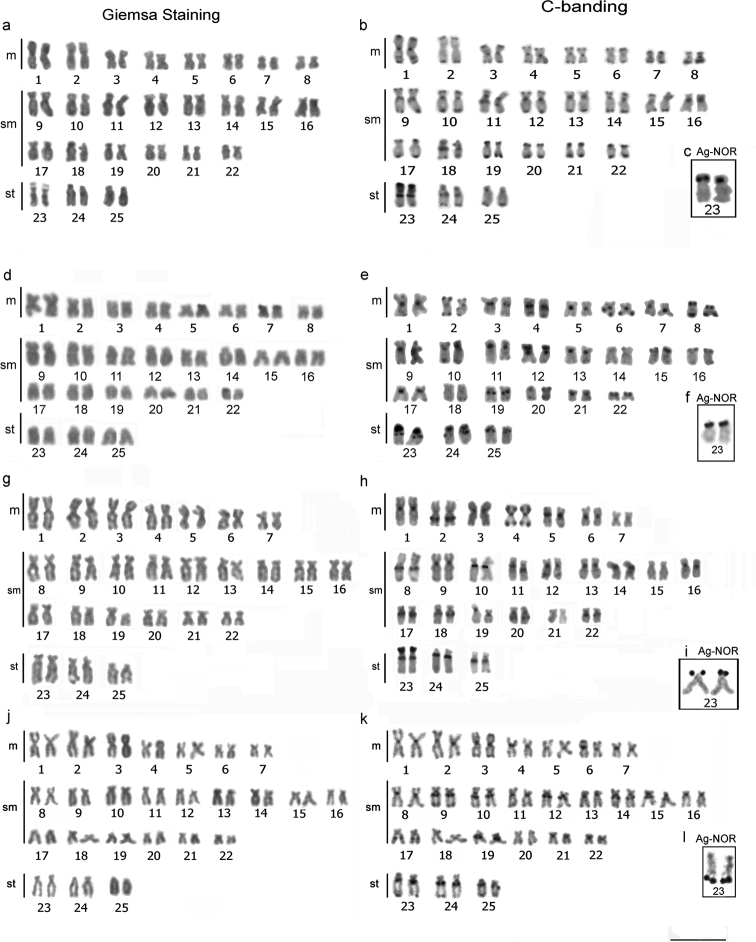
Karyotypes of the species under study arranged from chromsomes stained conventionally with Giemsa, C-banded, and after Ag-NOR impregnation: a–cA.
falcirostrisd–fA.
falcatusg–iA.
prope
microlepisj–lA.
microlepis. Scale bar: 10 µm.